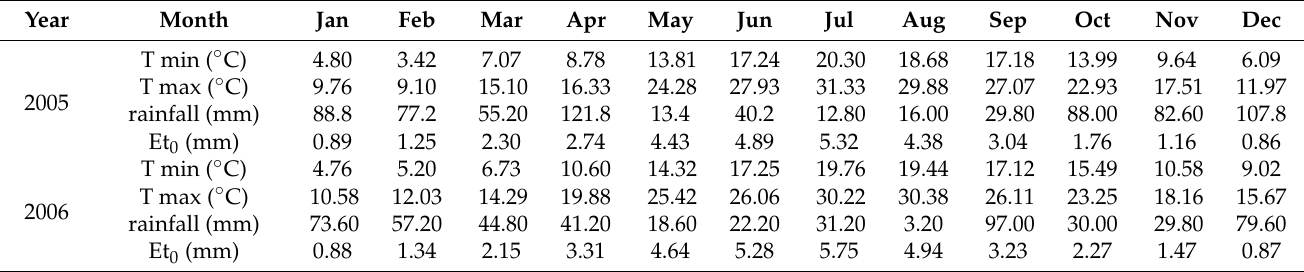
Table 1. Long term monthly average of temperature (T), rainfall and estimated ET 0 located at 680 m of distance (37 ◦ 45 (cid:48) 50.61 (cid:48)(cid:48) N, 13 ◦ 04 (cid:48) 13.73 (cid:48)(cid:48) E) from the experimental